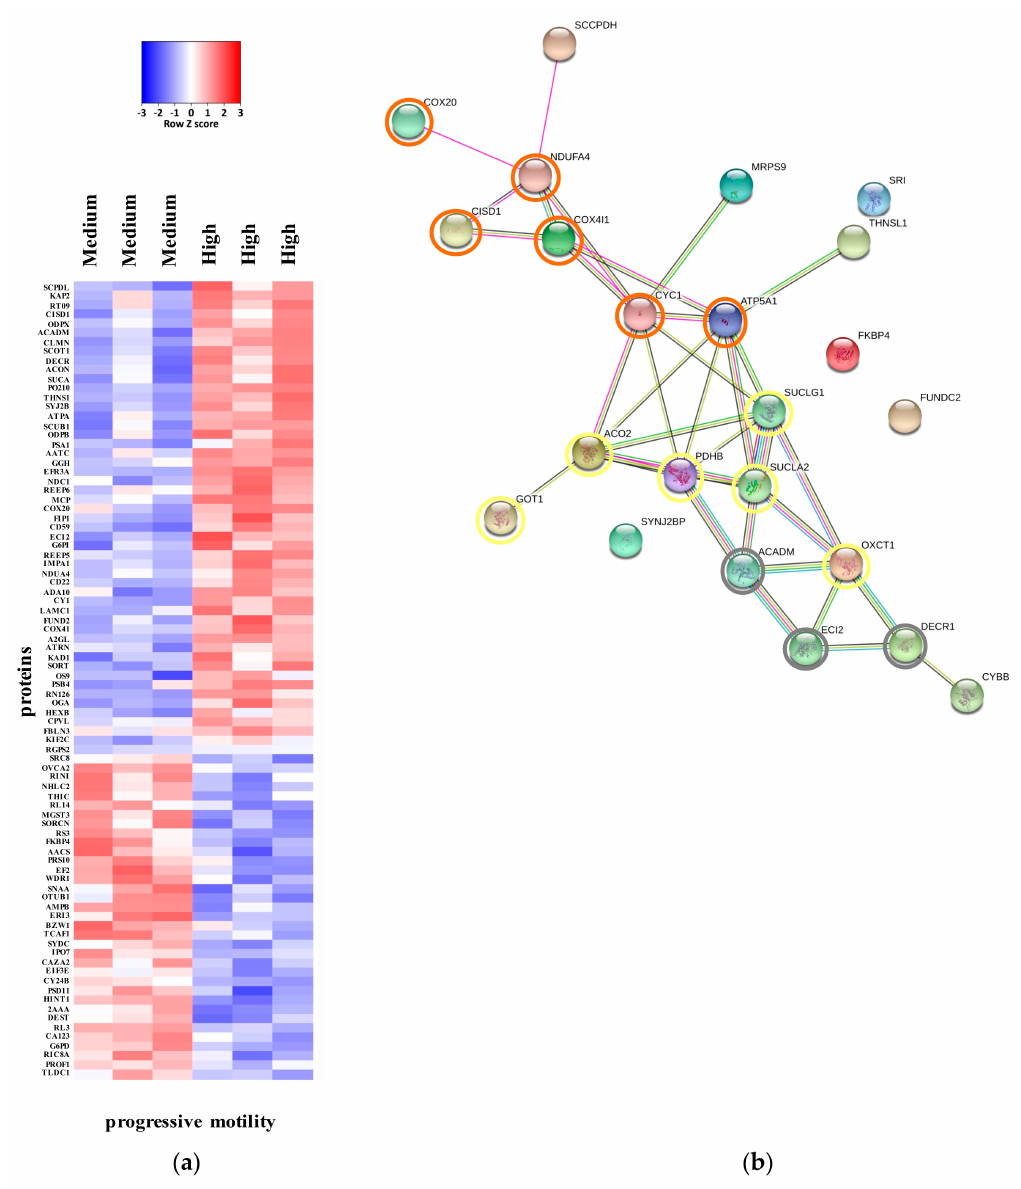
Figure 2. ( a ) Heat map of the expression of proteins which showed p < 0.05 in an unpaired, two tails t-test medium group (asthenozoospermic samples with ~24% of progressive motility) vs. high group (normozoosperic samples with ~44% of progressive motility). ( b ) Interactions among the three proteins involved in the polyunsaturated fatty acids catabolism (grey circles), Krebs tricarboxylic acid cycle (TCA) process (yellow circles) and oxidative phosphorylation (OXPHOS) process (orange circles) down-regulated in the human samples with medium progressive motility in comparison to normozoospermic samples. Interactions maps were prepared using the STRING database program. Thicker lines represent stronger associations, and thinner lines represent medium associations.